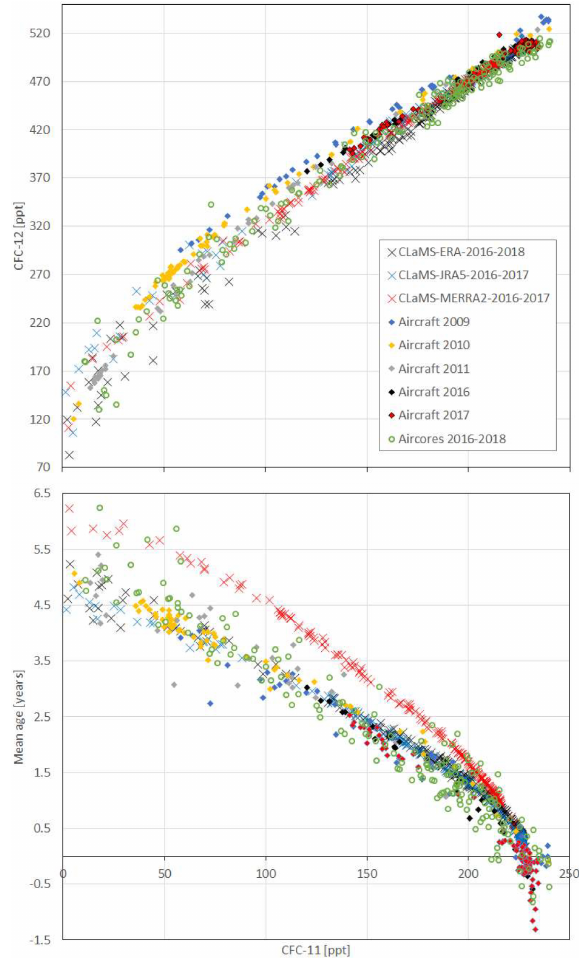
Figure 2. Stratospheric CFC-12 mixing ratios and the mean age of air (AoA) as a function of CFC-11 mixing ratios, as observed in air samples collected by research aircraft (diamonds) and Air- Core samples (circles). Crosses denote the values obtained from the CLaMS model sampled at the same times and coordinates as the observations but, for better visibility, only from 2016 onwards. The CLaMS model was run using three different meteorological reanal- ysis packages: ERA-Interim (black), JRA-55 (blue), and MERRA-2